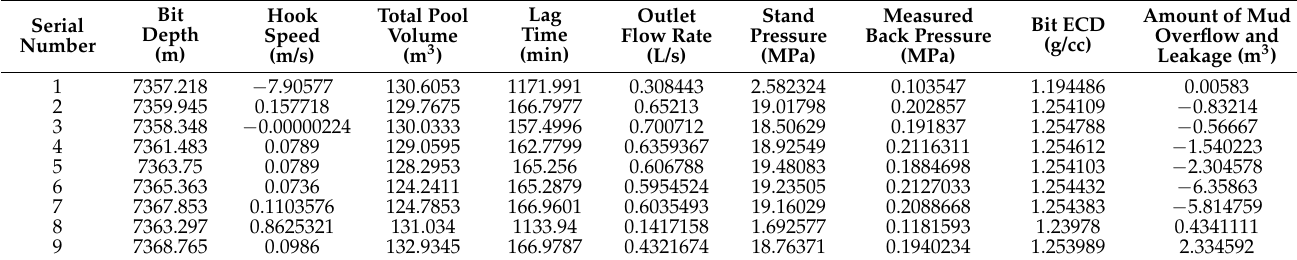
Table 2. Mud overflow and leakage and some influencing parameters.